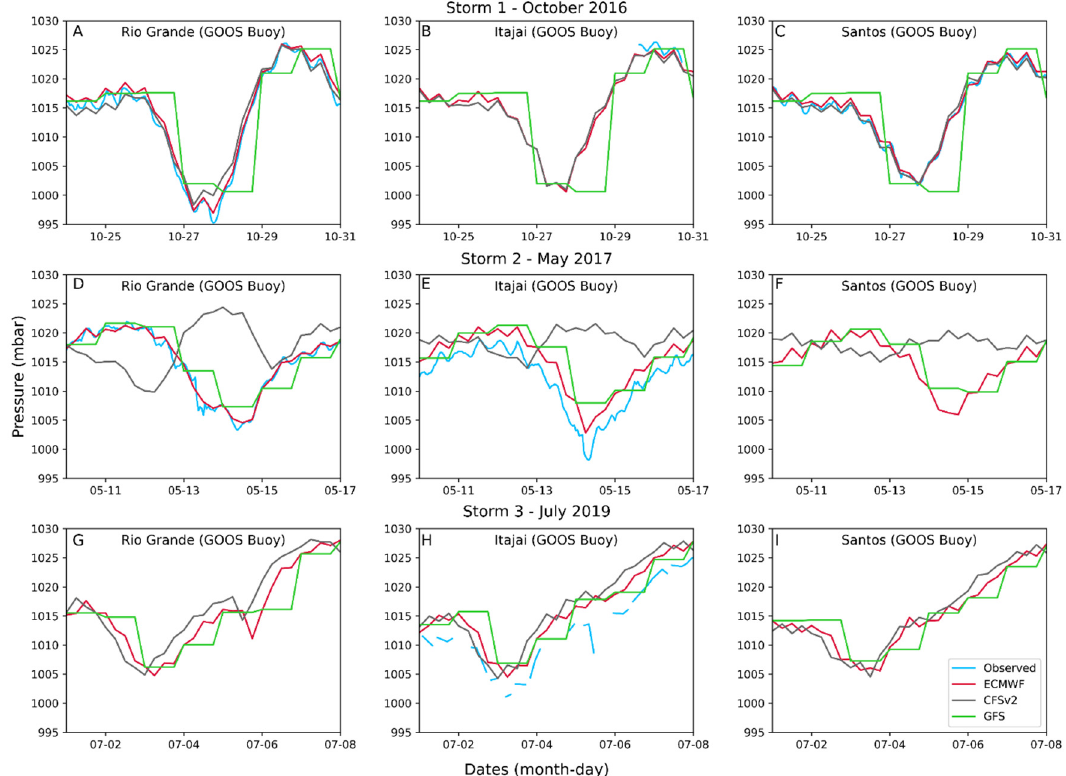
Figure 7. Air pressure at mean sea level time series at three different buoys ( A – I ).